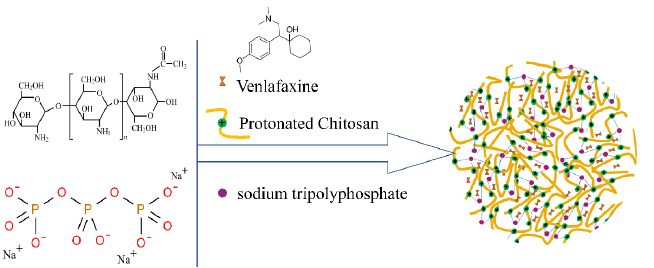
Figure 4. Chitosan is protonated under acidic conditions, and then ionically cross-linked with negatively charged sodium tripolyphosphate to prepare chitosan